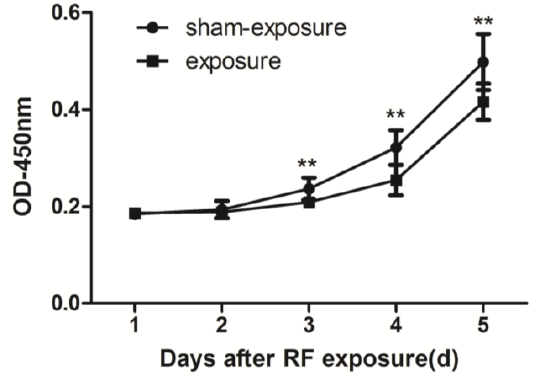
Figure 2. Proliferation of TM3 Leydig cells at day 1 to day 5 following exposure to radiofrequency (RF) electromagnetic radiation. Values represent mean ± SEM for each of the exposure and sham-exposure groups at each time point. ** p < 0.01 vs. sham-exposure (Student t -test).